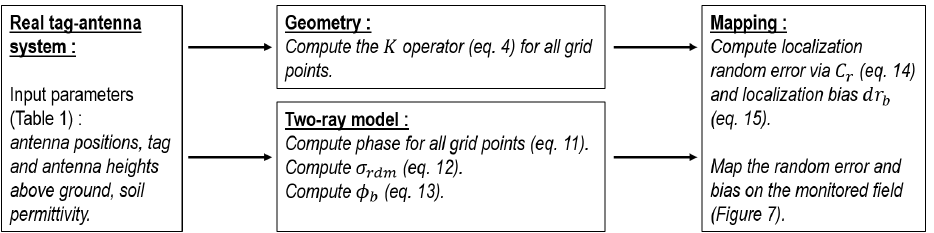
Figure 7. Schematic view of the workflow used to estimate the localization error and bias in the real-scenario Harmalière geometry.